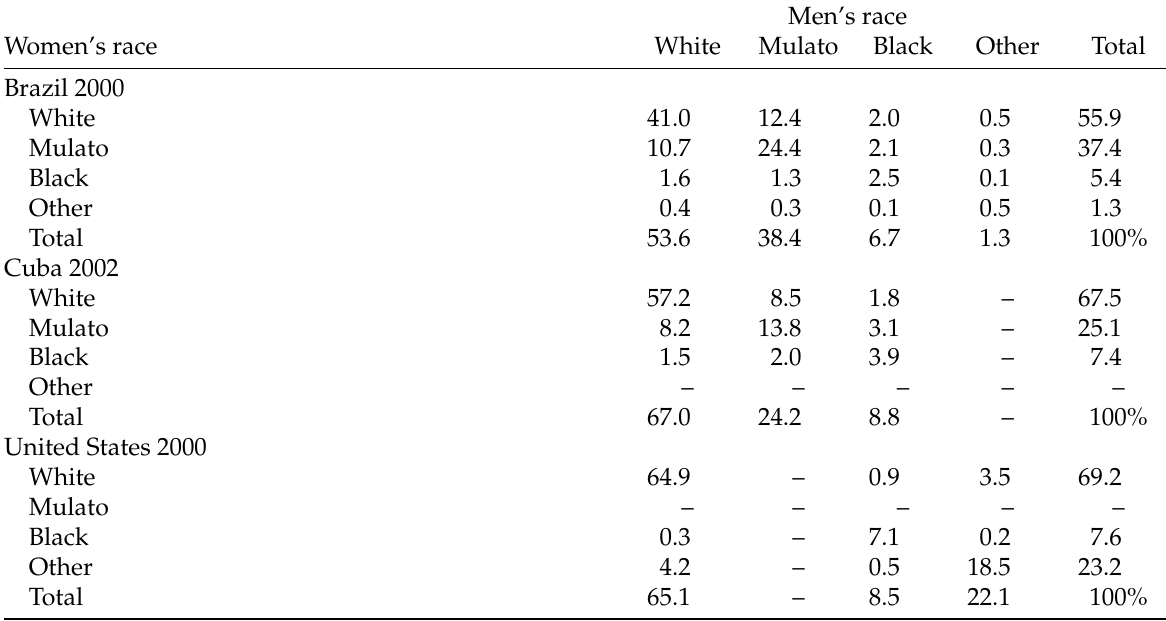
Table 3: Distribution of unions by race of the partners; women in unions aged 25 to 34 (Brazil 2000, Cuba 2002, and the United